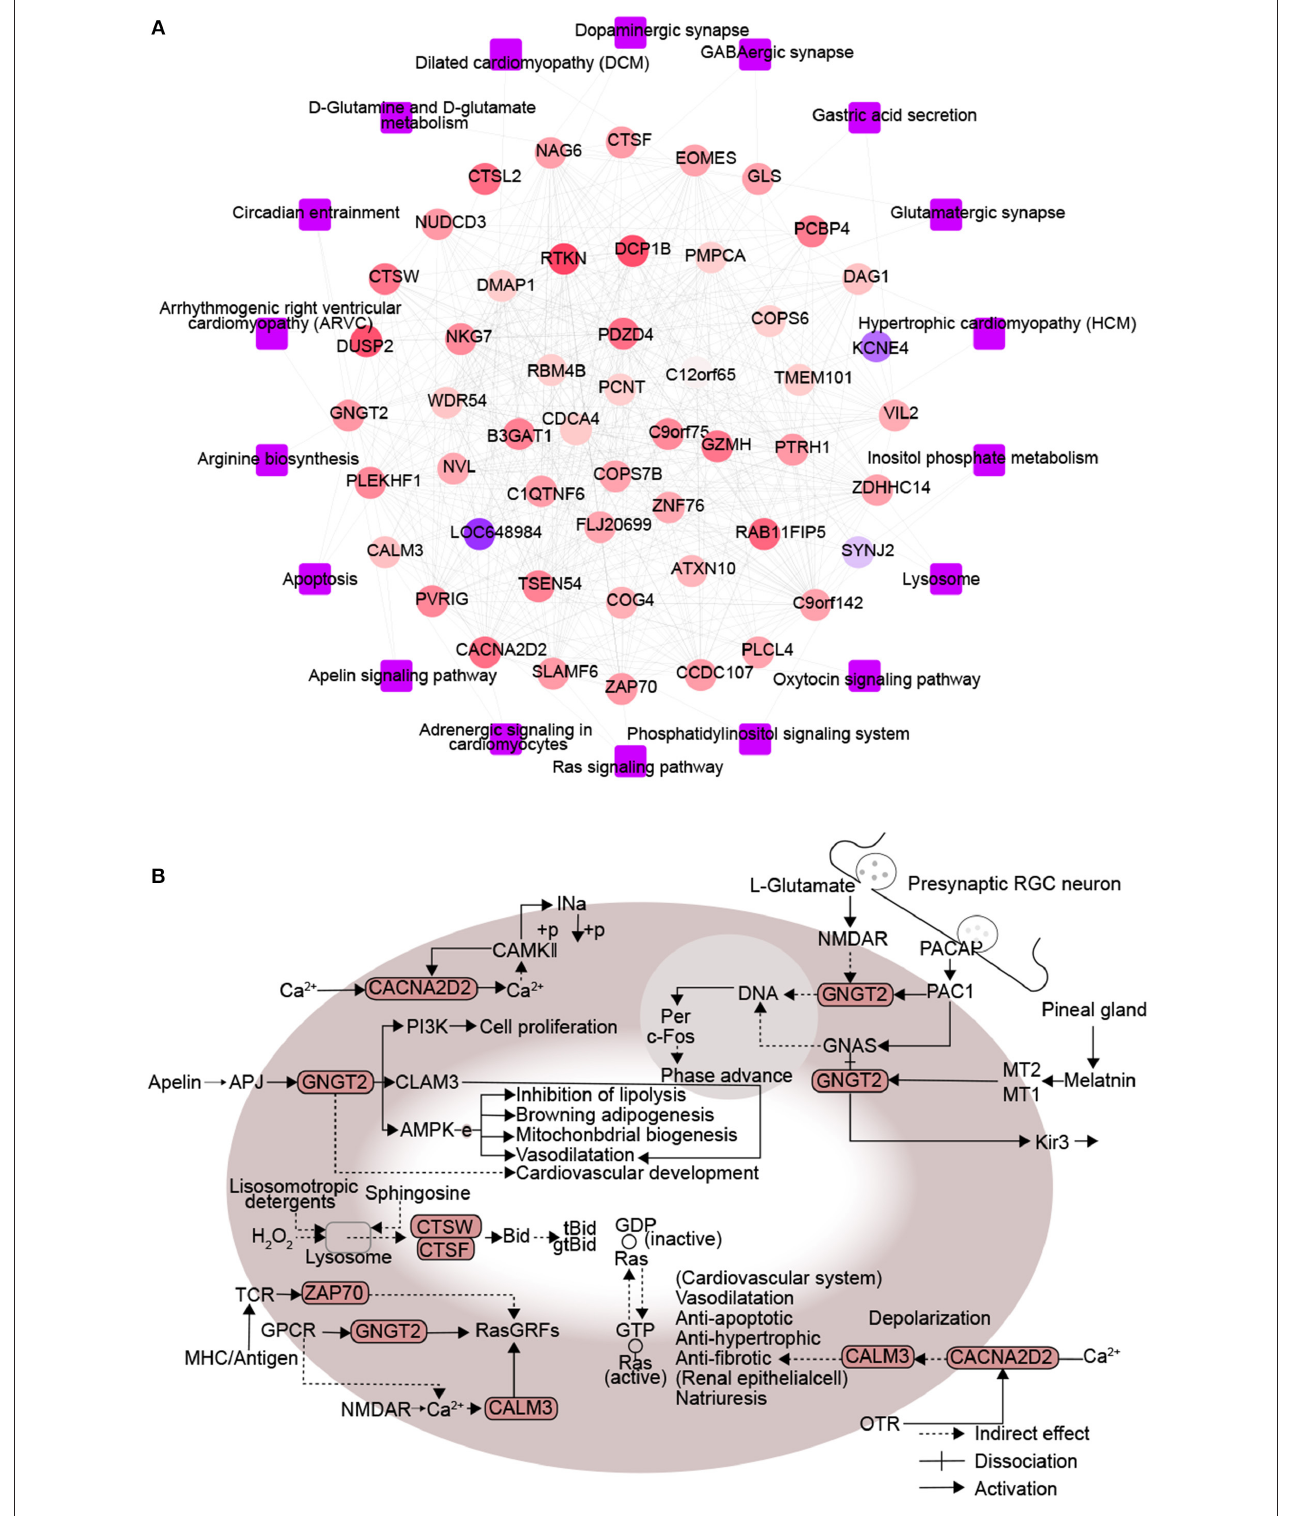
FIGURE 3 | Protein interactions associated with signaling pathways enriched in diabetes mellitus-associated coronary heart disease. (A) Network diagram of protein-protein-KEGG pathway related to DMCAD. The ellipse for the module gene. The round rectangle for the KEGG pathway. The color of gene nodes represents MM, and the color at the edge of gene nodes represents modules. (B) CALM3, ZAP70, GNGT2, CACNA2D2, CTSF, and CTSW-related KEGG pathways. DMCHD, diabetes mellitus-induced coronary heart disease. DRAG, DM-related atherogenesis gene. MM, module membership.